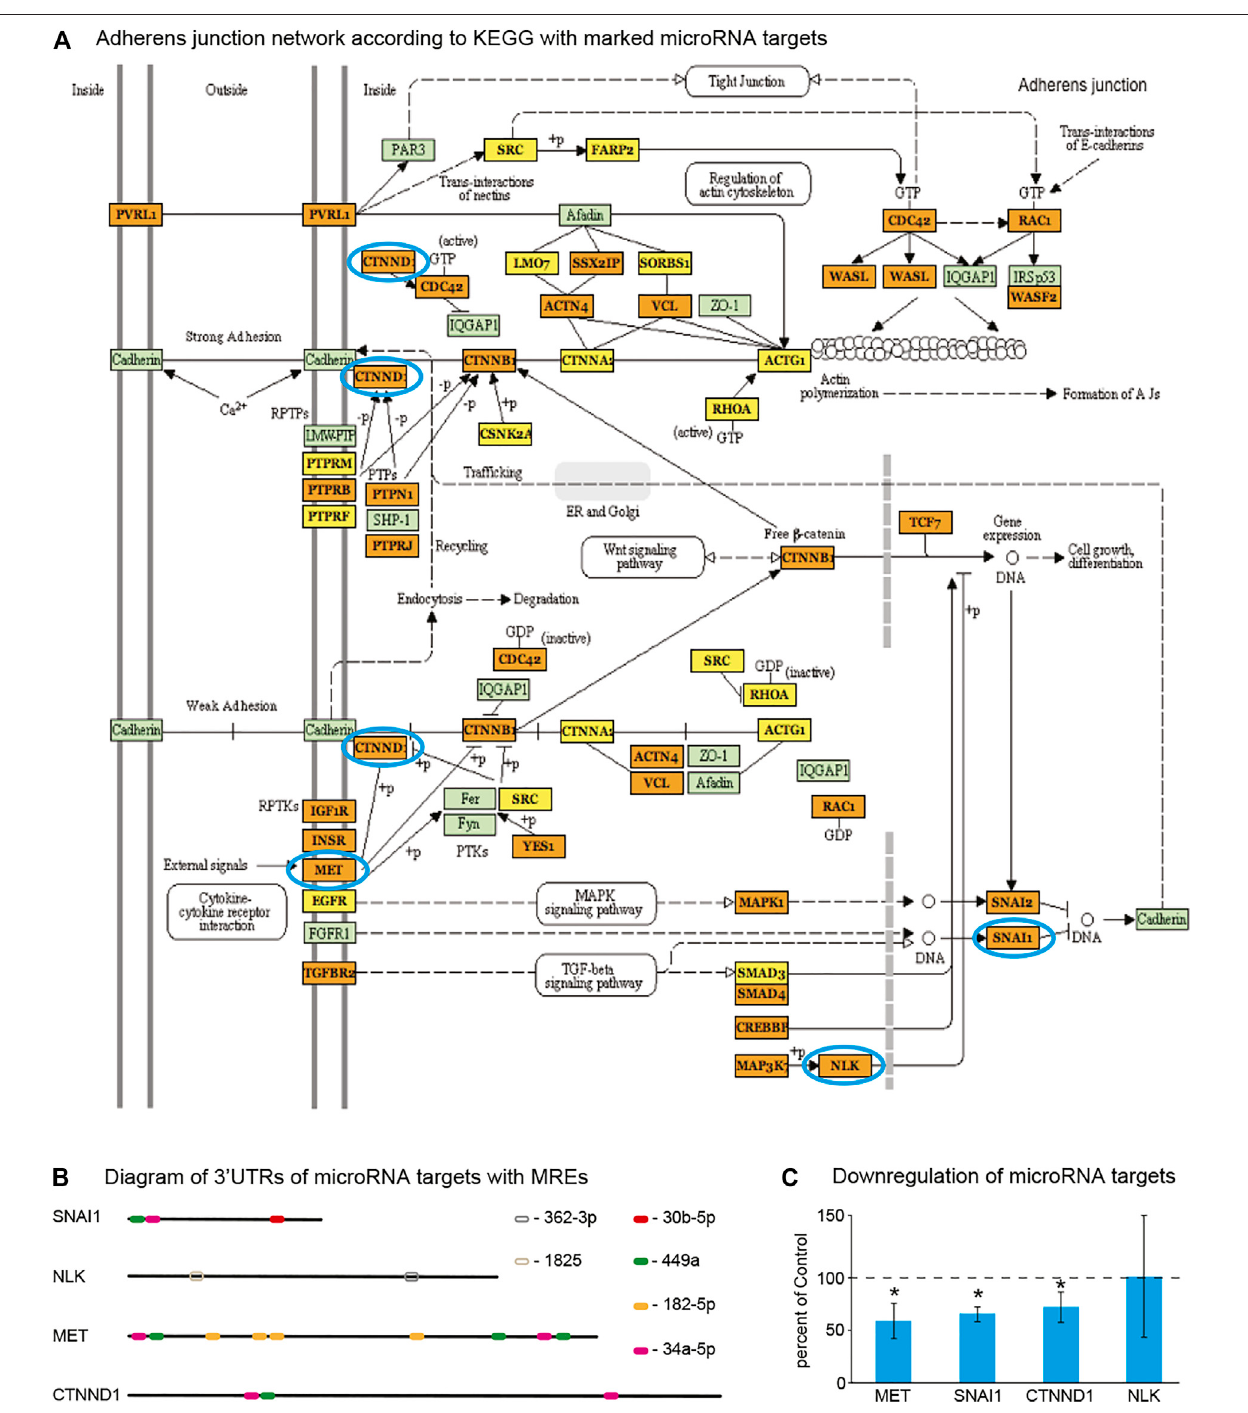
FIGURE 2 | A wiring diagram showing potential regulation of adherens junction pathway by microRNAs relevant in alcohol abuse. (A) The diagram shows relationships of several gene products important for the proper function of the adherens junction. It also shows links to other pathways, some of them potentially regulated by alcohol. Gene products in yellow boxes are affected by one microRNA, gene products in orange boxes are affected by more than one microRNA. Gene products in green boxes are unaffected. Gene products in blue circles were tested by qPCR. The wiring diagram was created using KEGG (Kyoto Encyclopedia of Genes and Genomes) and DIANA-mirPath software with FDR correction and p -value threshold of 0.05. (B) Diagram of 3 ′ UTRs of four genes [gene products in blue circles in (A) ] targeted by several alcohol-regulated microRNAs (see the legend) showing relative positions of individual microRNA responsive elements (MREs). Empty circles indicate hybridization energy between a microRNA and its target above − 20 kcal/mol. (C) Decreased expression levels of four microRNA targets marked in (A) and depicted in (B) in alcohol samples. GABDH was used as a reference. N ≥ 3. * - p < 0.05.